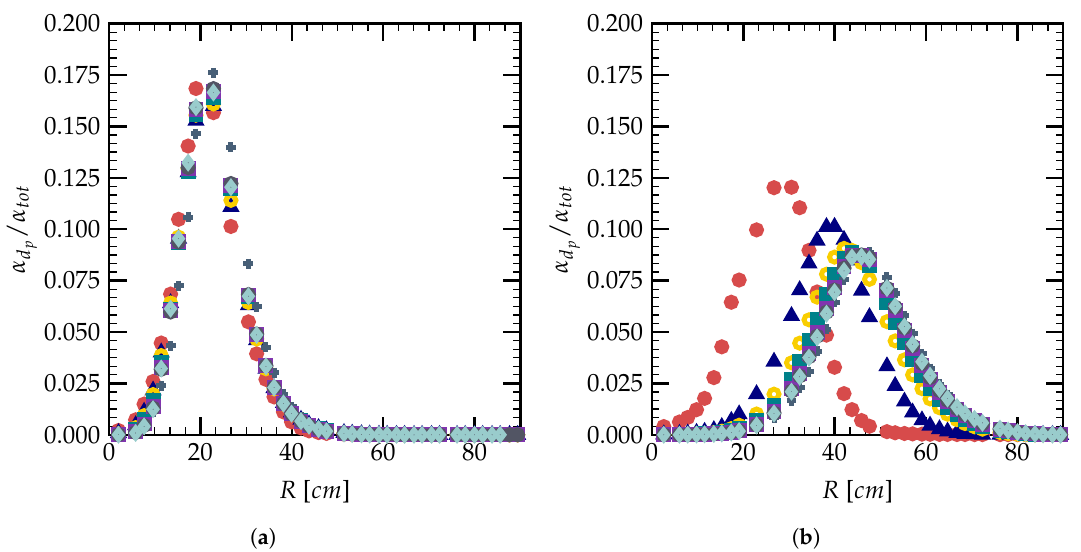
Figure 11. Evolution of normalized volume fraction α d 277 µ m ( ), d p = 388 µ m ( ), d p = 500 µ m ( ), d p = 611 µ m ( ), d p = 722 µ m ( ), d p = 833 µ m ( ), d p = 944 µ m ( ); ( a ) h = 40 cm and ( b ) h = 95